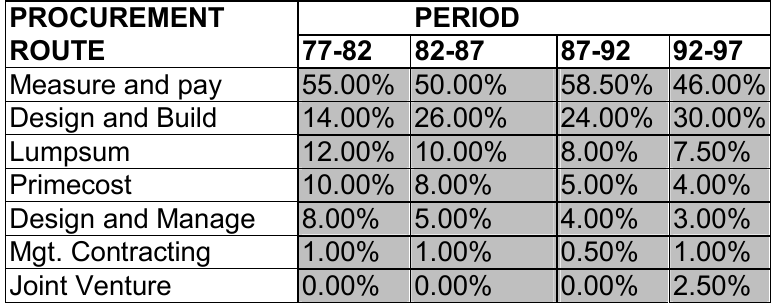
Table 5. Trends in contractual procurement arrangements (1977-1997)